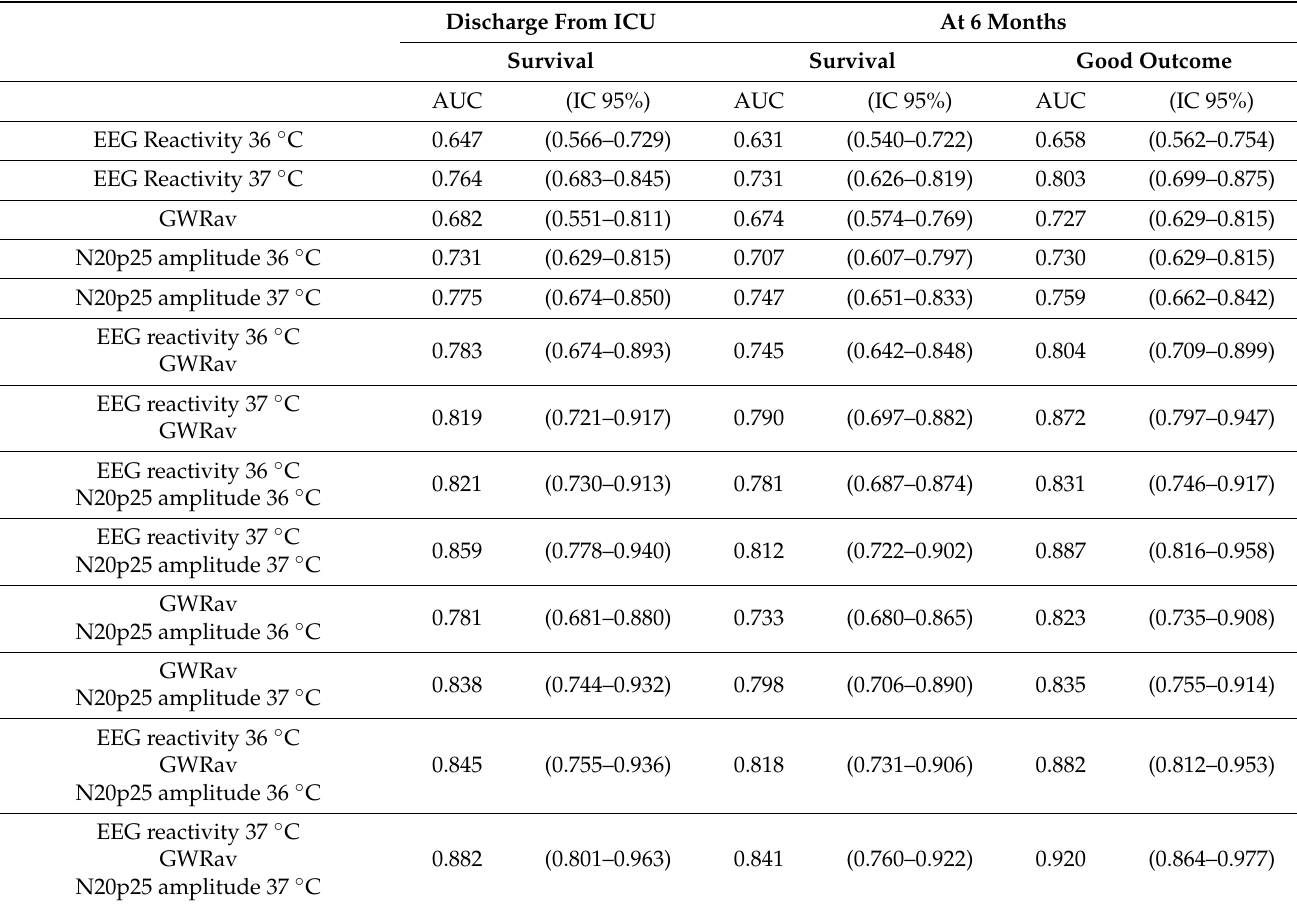
Table 4. AUC for EEG reactivity, average GWR, and SSEP N20P25 amplitude for predicting good outcome and survival. Discharge From ICU At 6 Months Survival Survival Good